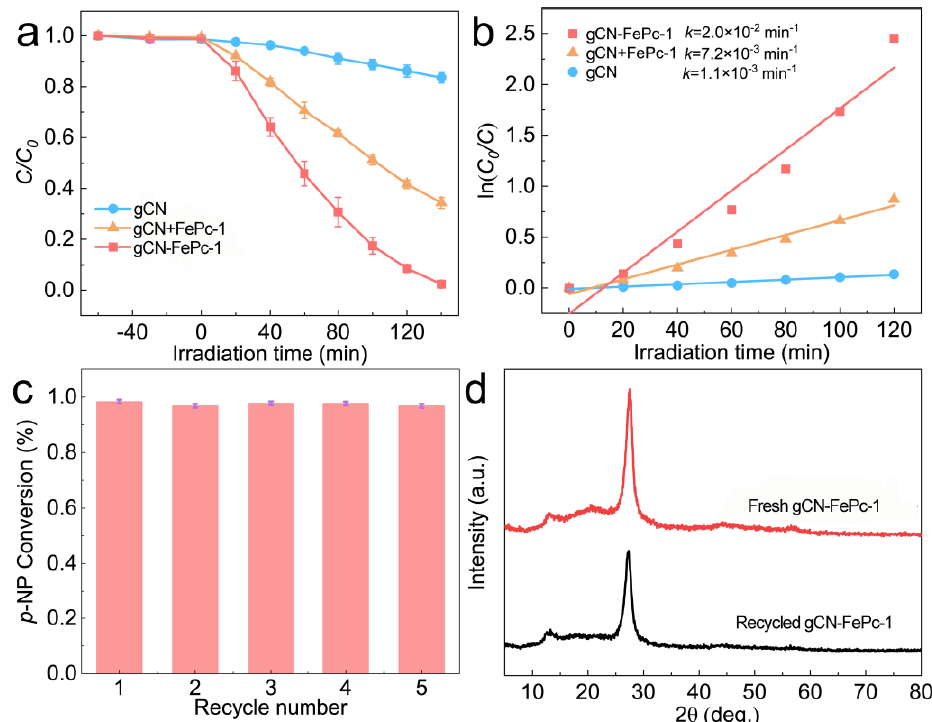
Figure 7. Photocatalytic reduction in p -NP over different photocatalysts under visible light irradiation ( a ); the corresponding pseudo-first-order kinetic curves and the apparent rate constants ( b ); cycle stability test of gCN-FePc-1 ( c ); XRD patterns ( d ) of the fresh gCN-FePc-1 and the recycled gCN-FePc- 1. The experimental data in Figure 7 ( a – c ) are based on three repeated experiments.